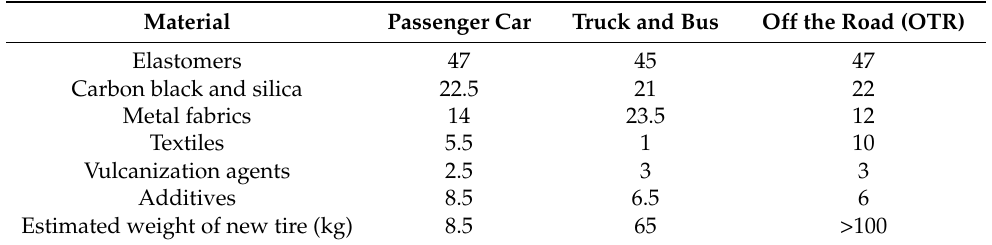
Estimated weight of new tire